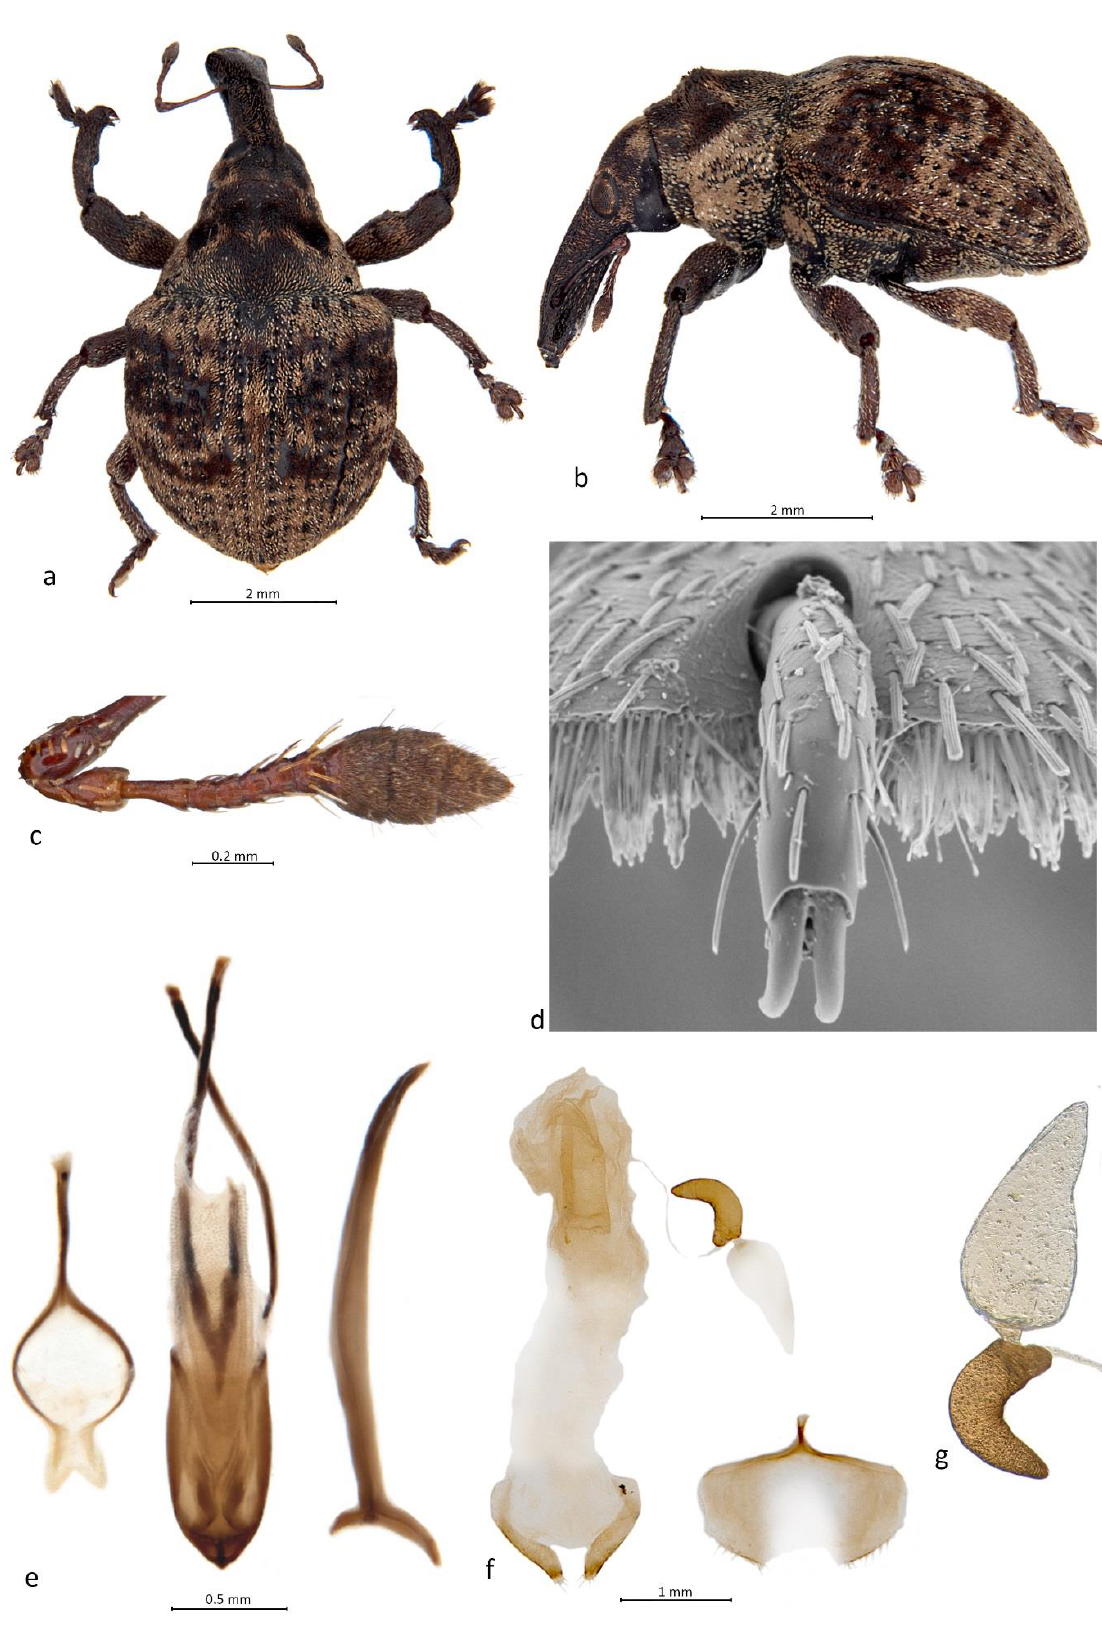
Figure 6. Habitus and diagnostic characters of Menechirus oculatus Hartmann: ( a ) habitus of male, dorsal view; ( b ) habitus of male, left lateral view; ( c ) right antenna, male, dorsal view; ( d ) tarsite 3 with onychium, apical view; ( e ) genitalia, male, dorsal view; ( f ) genitalia, female, dorsal view; ( g ) spermatheca with gland.